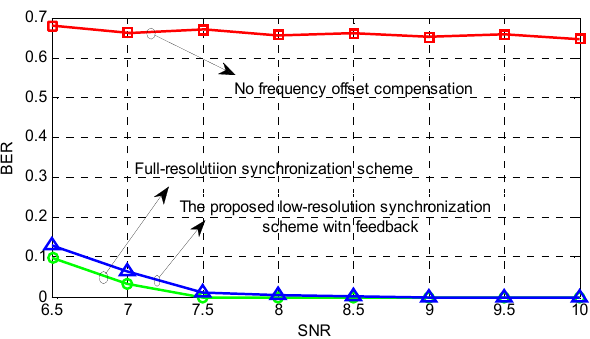
Figure 9. Performance comparison of the synchronization schemes.